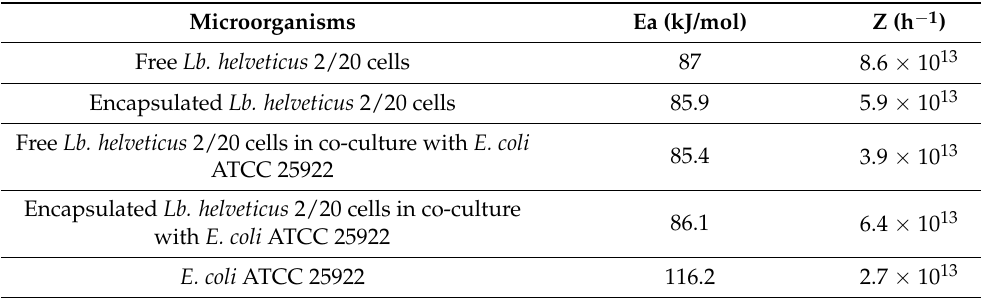
Table 3. Activation energy of growth and pre-exponential multiplier in the Arrhenius equation for Lb. helveticus 2/20 and E. coli ATCC 25922 in chocolate mousse. Microorganisms Ea (kJ/mol) Z (h − 1 )